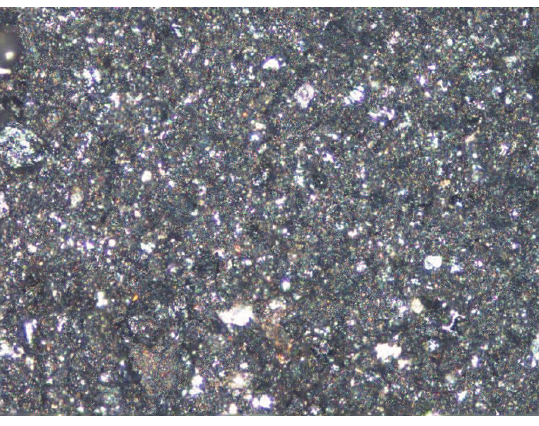
Fig. 9. Microscope image (magnification 100 ×, reflected light) of the sediment collected from the exhaust nozzle levers After the sediments from the outer surface of the ana- lyzed zones were washed with chloroform, the sample was analyzed in the infrared spectrum. The fuel residue and the engine oil residue were observed, as well as degradation products. The IR spectrum for the substances isolated in the 3rd opening of the injector is poorer (Fig. 10). At first a comparative analysis was conducted of hydrocarbon bands, i.e. the range of wave numbers: 2850–3000 cm –1 , 1464 cm –1 , 1377 cm –1 , 722 cm –1 [10]. In both cases, the back- ground was more raised, which is related to the presence of soot. In addition, vibration bands typical for hydroxyl groups (about 3400 cm –1 ) are present, which may be de- rived from the absorbed water, and also from the alcohol and carboxylic acids structures [10].